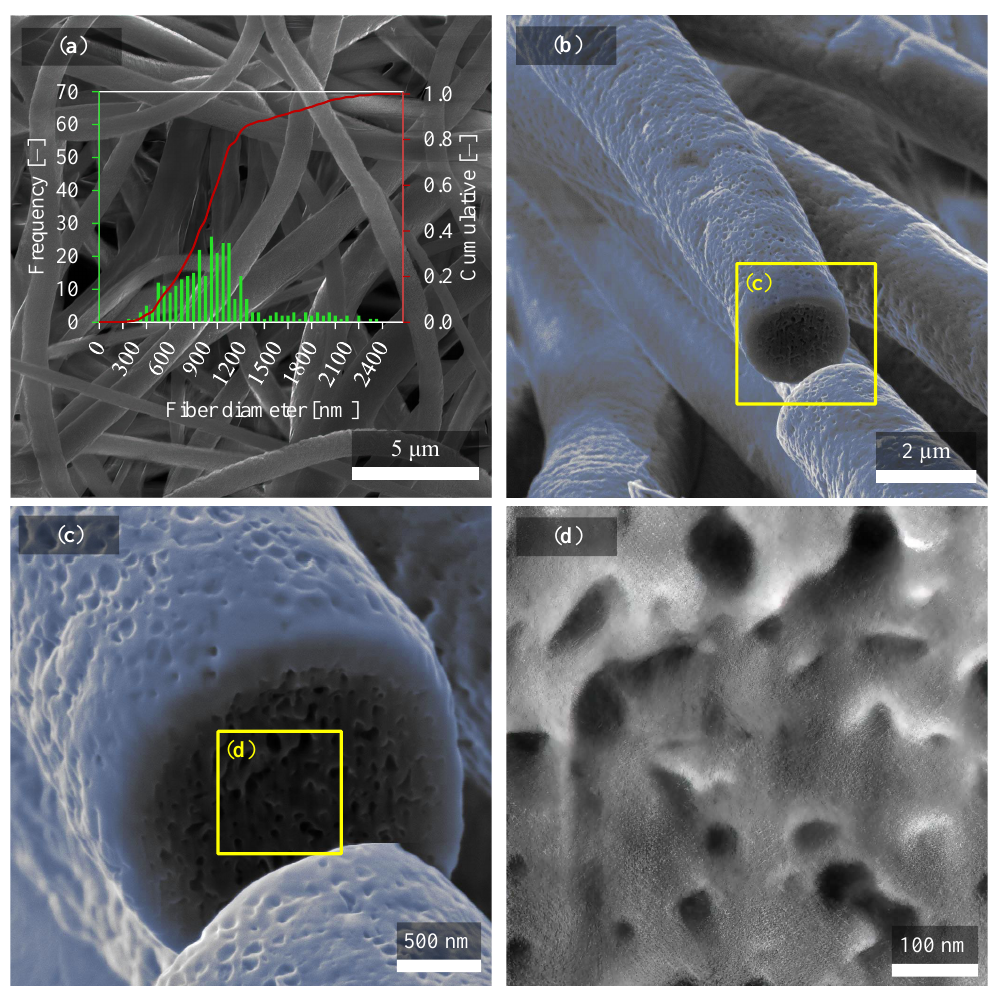
Figure 2. ( a ) SEM image of PVDF fibers prepared at 300rpm with ( b ) detail of PVDF nanofiber in cross-section and its porous structure after fabrication with 300rpm of collector speed. All four figures describe the same fiber structure. The cross-section highlighted in ( b ) is more in detail shown in ( c ) and in maximized detail in ( d